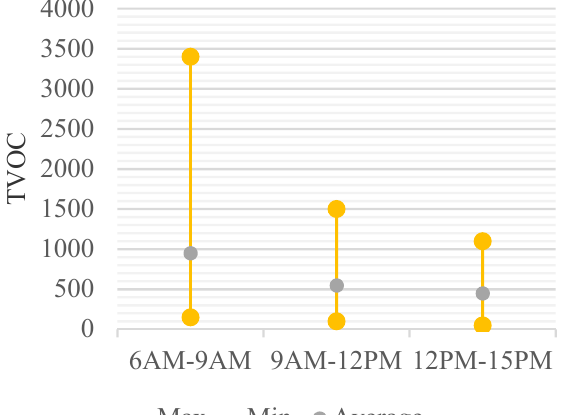
Figure 11. Daily Concentration Change of TVOC.